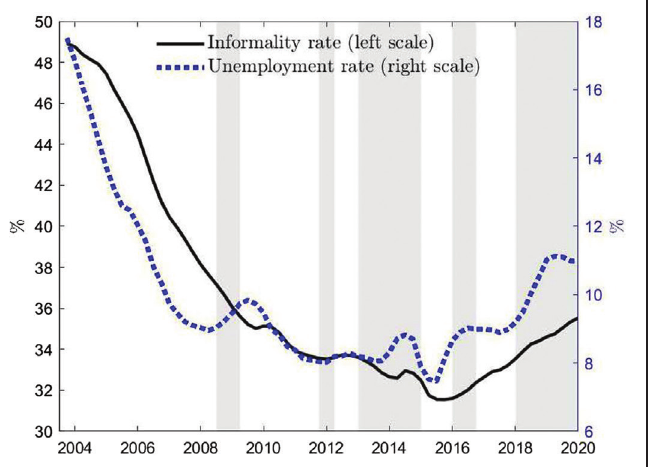
Figure 1 Informality rate and unemployment rate in Argentina (in